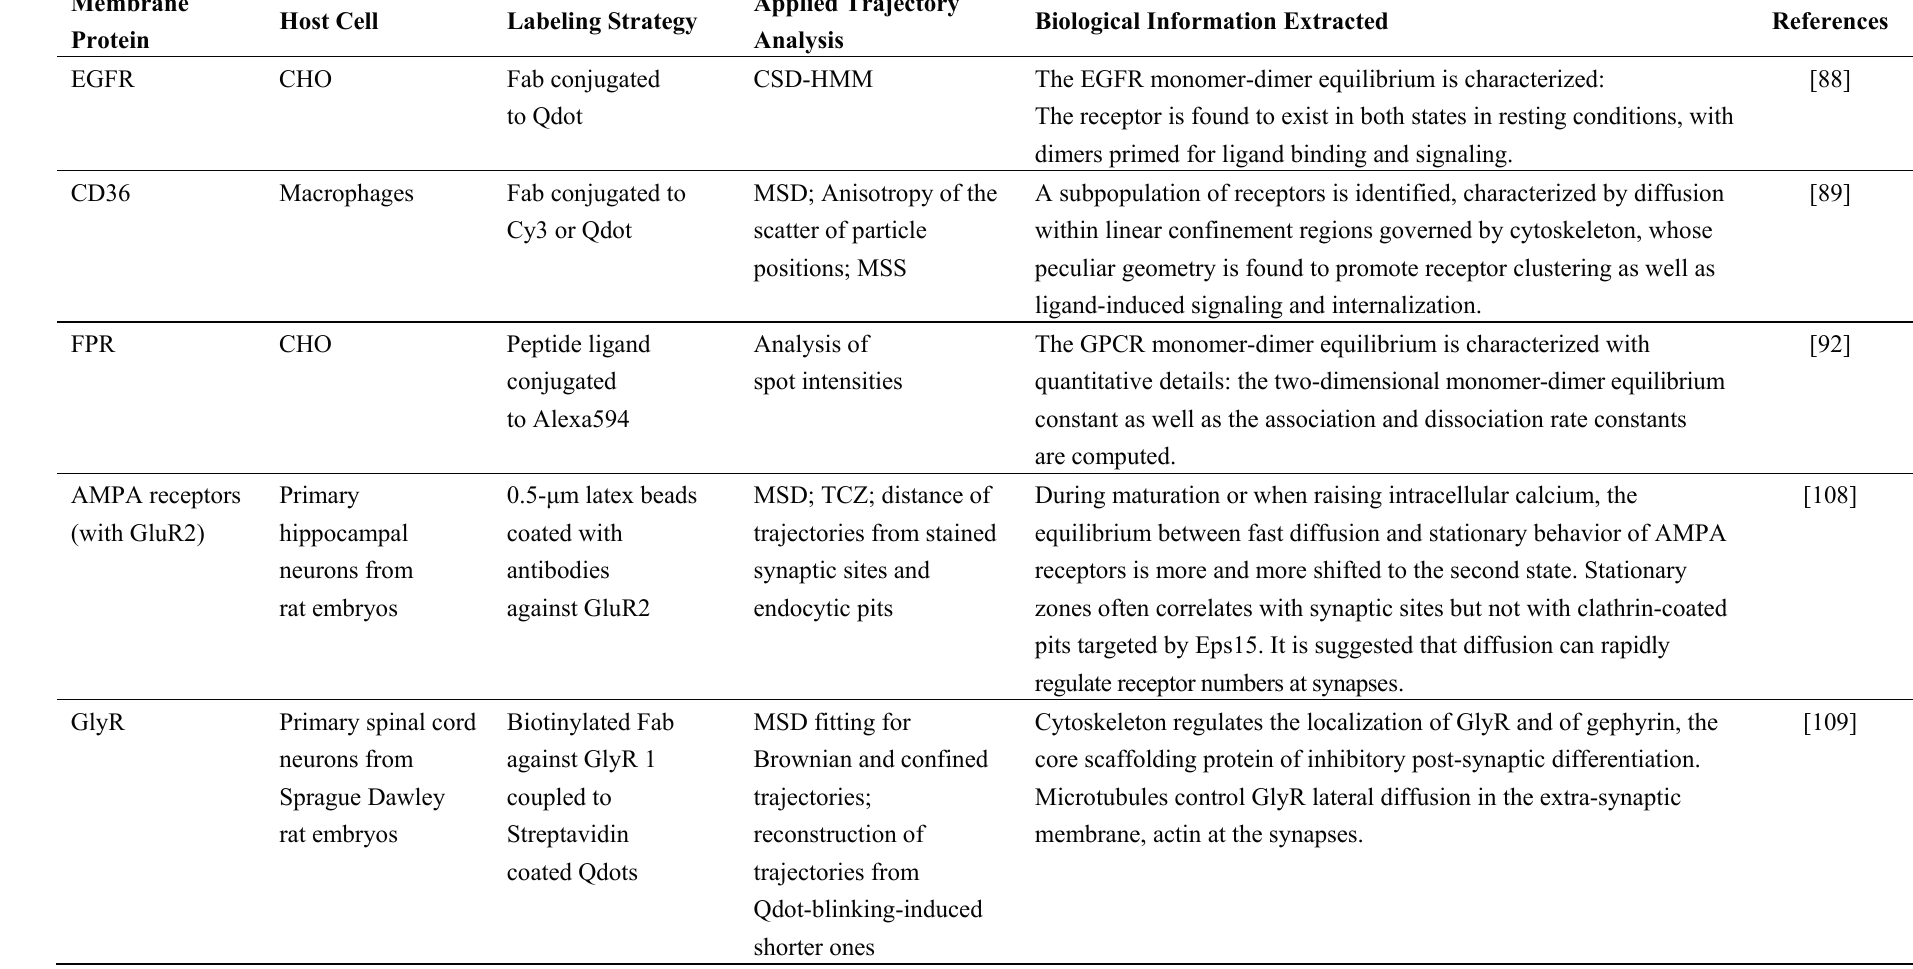
Table 1. SMI-SPT analysis approaches to the study of membrane